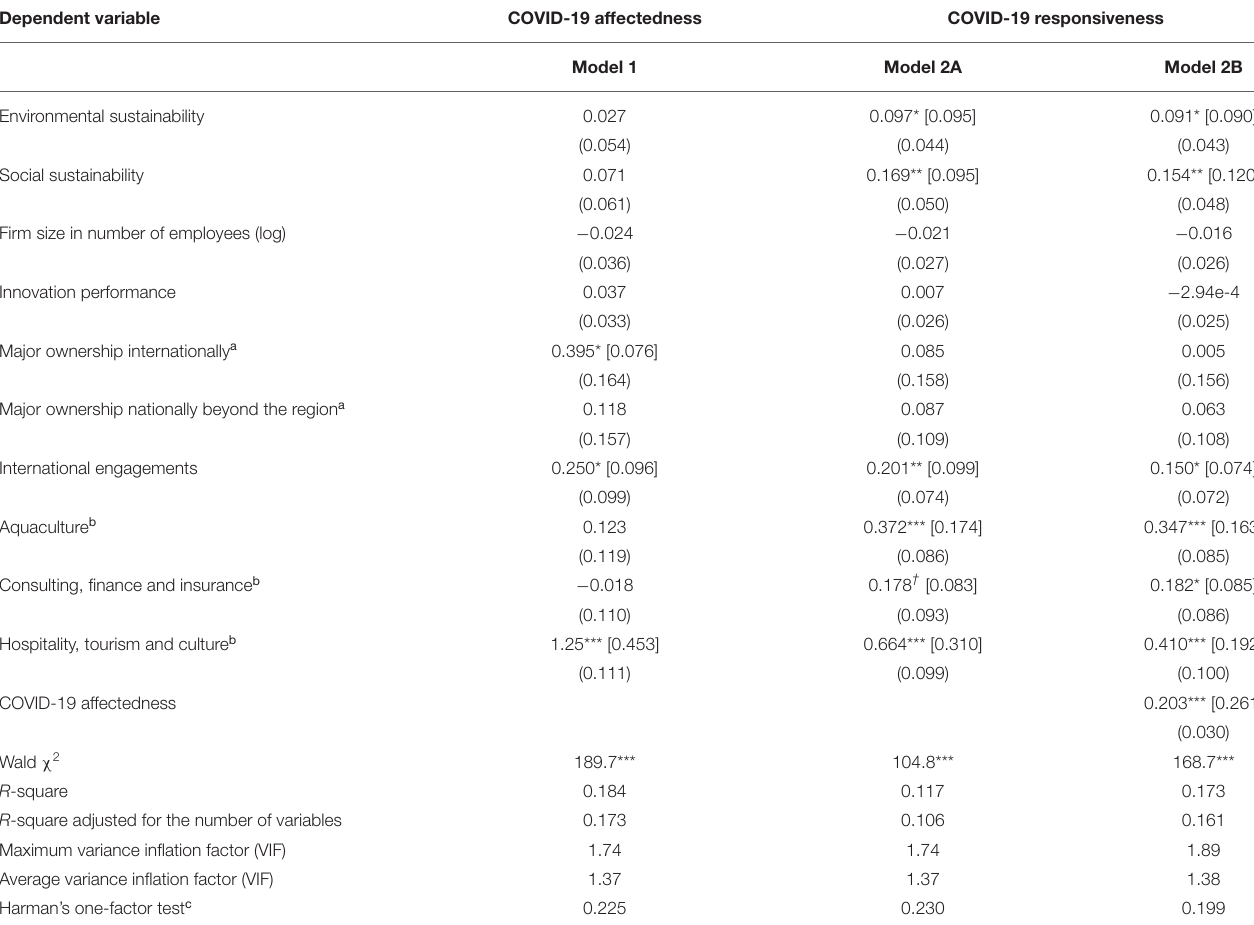
TABLE 3 | Bootstrapped ordinary least square